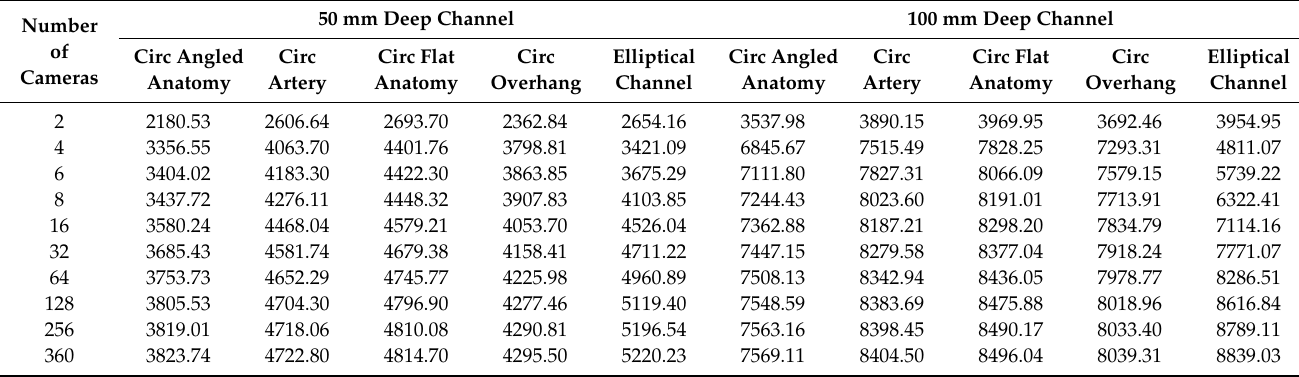
Table A1. Absolute values of the models including the mesh top surface.